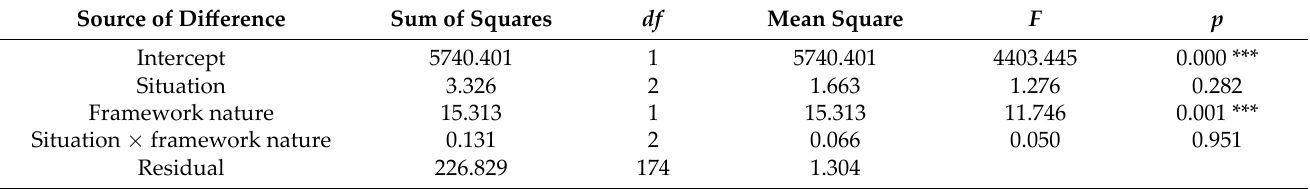
Table 3. Two‑Way ANOVA Results.